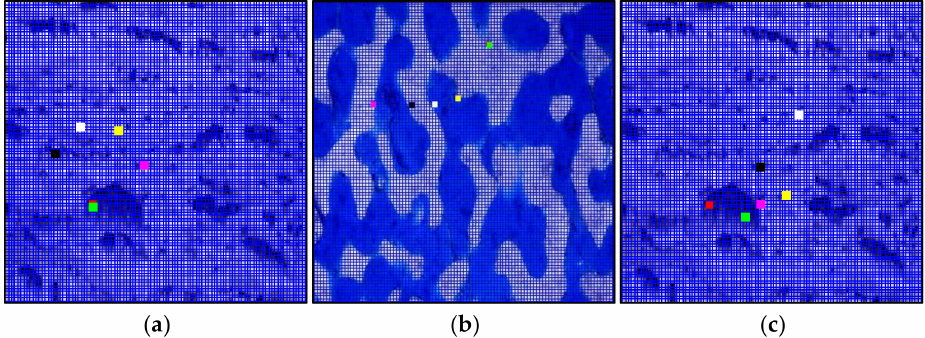
Figure 17. Comparison of search and location area results by different methods. ( a ) Macro– mesoscopic search; ( b ) Mesoscopic–micro search; ( c ) Macro–micro